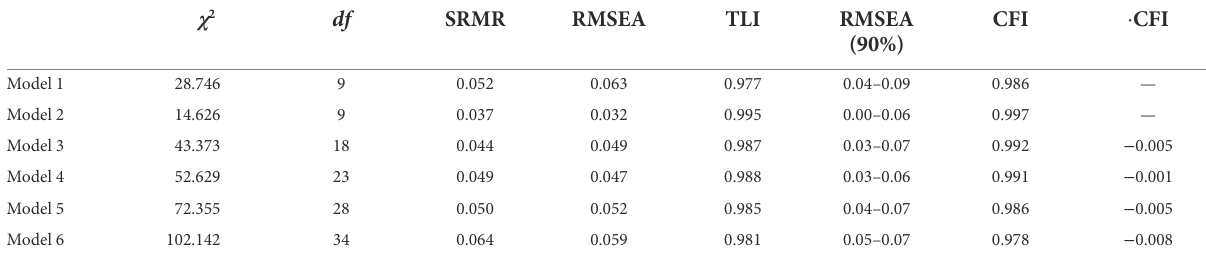
TABLE 3 The goodness of fit statistics for tests of cross-cultural equivalence of the PDSS in Brazil and Angola. χ 2 df SRMR